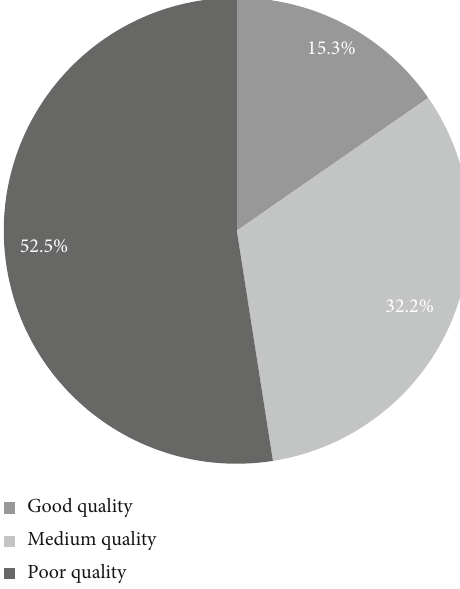
Figure 2: Category of contents regarding hydroponic technology based on